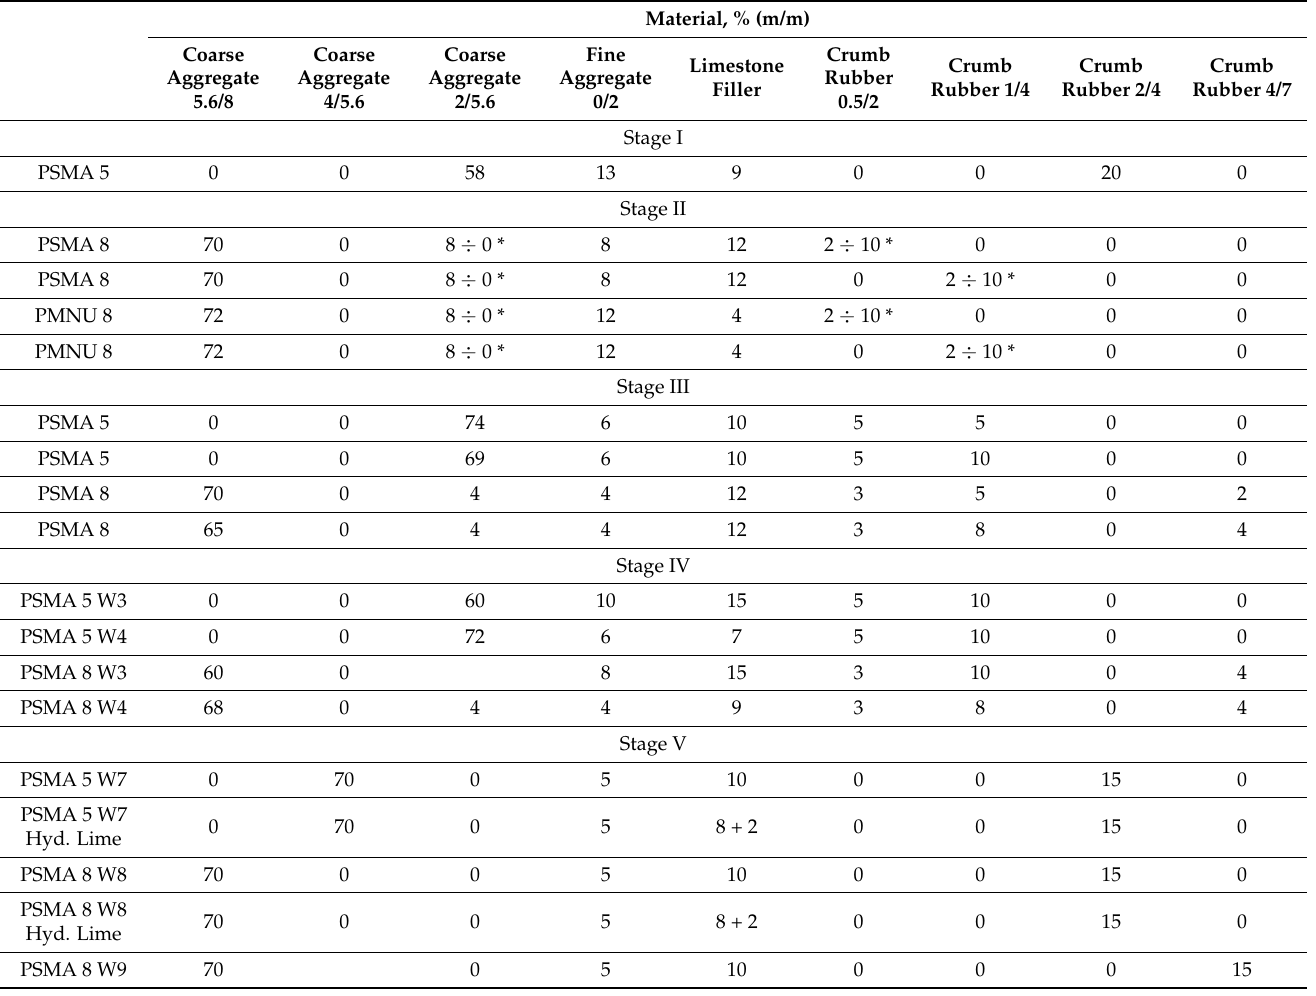
Table 3. Composition of poroelastic SEPOR